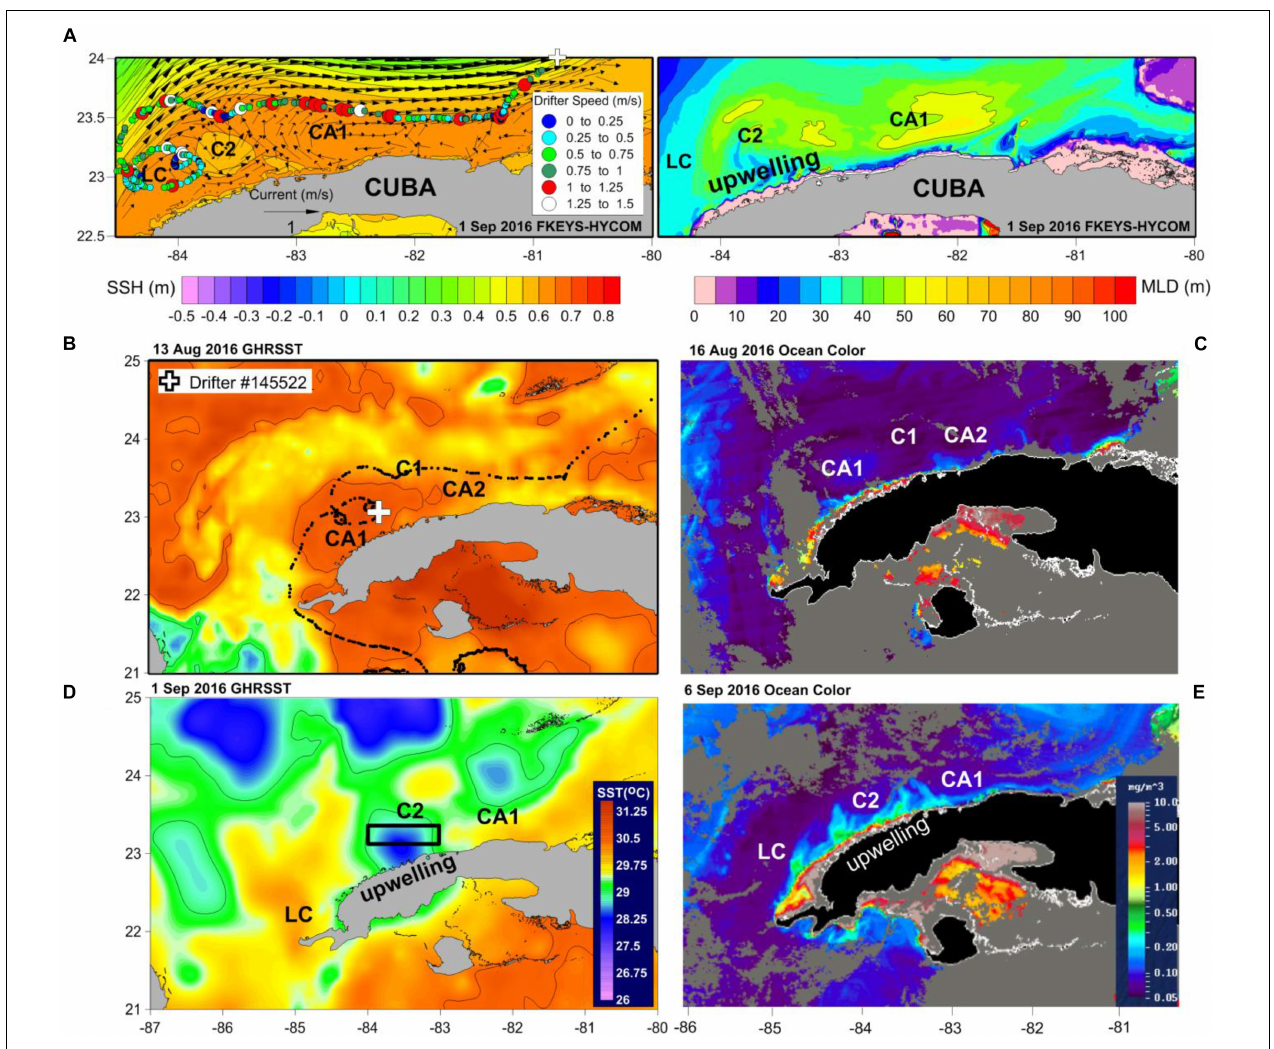
FIGURE 2 | Horizontal distribution of (A) Sea Surface Height (SSH) and near-surface currents and Mixed Layer Depth (MLD) derived from the FKEYS-HYCOM 1/1000 model simulation on September 1, 2016. Horizontal distribution of satellite observations: (B) SST (GHRSST) and (C) satellite ocean color in mid-August 2016 (middle panels) and the respective (D) SST and (E) ocean color in early September 2016 (lower panels). A drifter trajectory along the Straits of Florida is marked on (A) , circle colors denoting drifter speed (in ms − 1 , values in the box insert); speeds over 1 ms − 1 (red and white) are marked by larger circles; white cross symbols in panels (A) and (B) indicate the drifter’s position on the particular date. The loop current (LC), the cyclonic eddies C1, C2, the anticyclonic eddies CA1, CA2 and the upwelling area along the northern Cuban coast are also marked. “Upwelling” marked over the Cuba land mass indicates upwelling area near the coast (marked by cooler/blue color waters in GHRSST data and more productive/green color waters in ocean color data). We use GHRSST Level 4 SST fields produced by GHRSST daily Level 2 data Donlon et al. (2009), https://podaac.jpl.nasa.gov/dataset/JPL-L4UHfnd-GLOB-MUR, with horizontal resolution of 1–2 km (adapted from Kourafalou et al.,